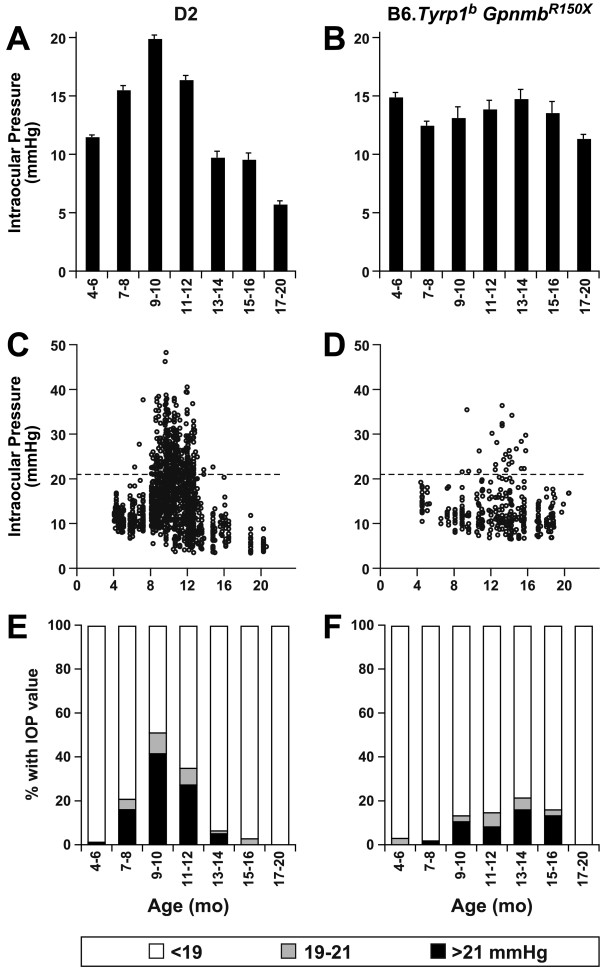
B6.Tyrp1b GpnmbR150X mice are relatively resistant to IOP elevation. Graphs of IOP and age for D2 mice (left column) versus B6.Tyrp1b GpnmbR150X mice (right column), with the same data represented as: (A and B) bar graphs of mean IOP +/- SEM (>30 mice per bin), (C and D) scatter plots, and (E and F) plots showing percent of mice with IOP of indicated values. IOP was recorded from a total of 336 B6.Tyrp1b GpnmbR150X mice and 1437 D2 mice. All groups contained >30 mice and included both male and female mice.